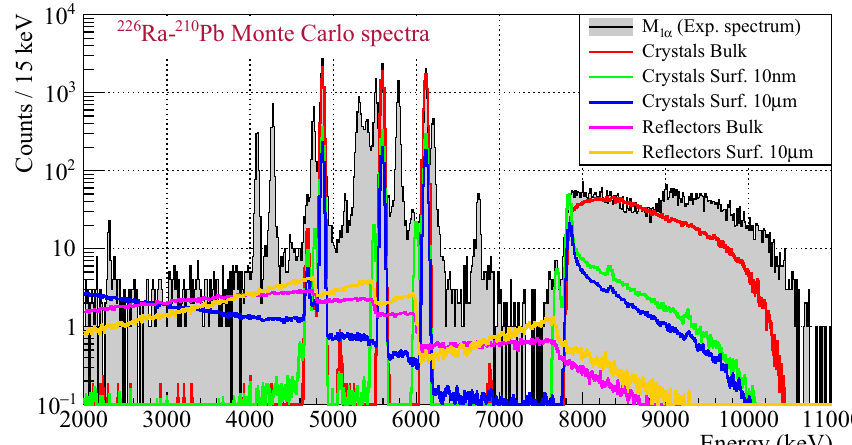
Fig. 4 Comparison among the spectra of a 226 Ra source simulated in Crystals or in Reflectors , both in the bulk and on the surface of each element. Distinctive Q-value peaks characterize all crystal spectra and, in case of surface simulations, there are also smaller peaks at α energies or a continuum spectrum of degraded α s, depending on contaminant